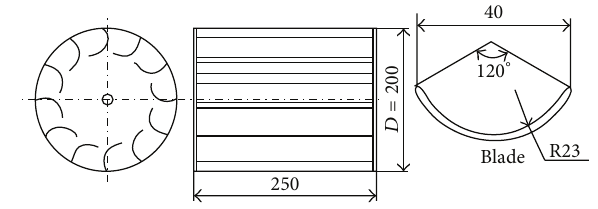
Figure 1: Rotor and blade specifications.